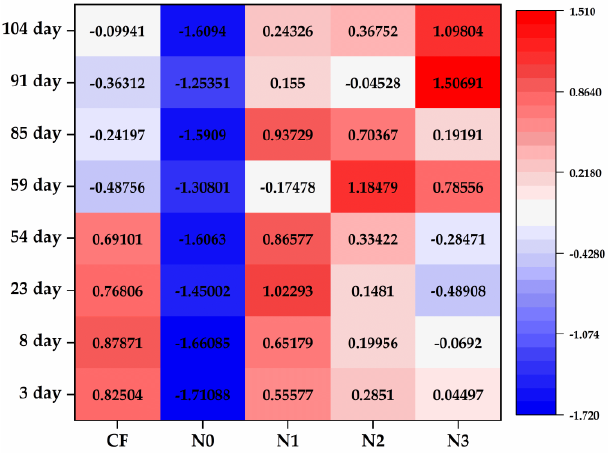
Figure 1. Heat map analysis of soil urease activity in different treatments.